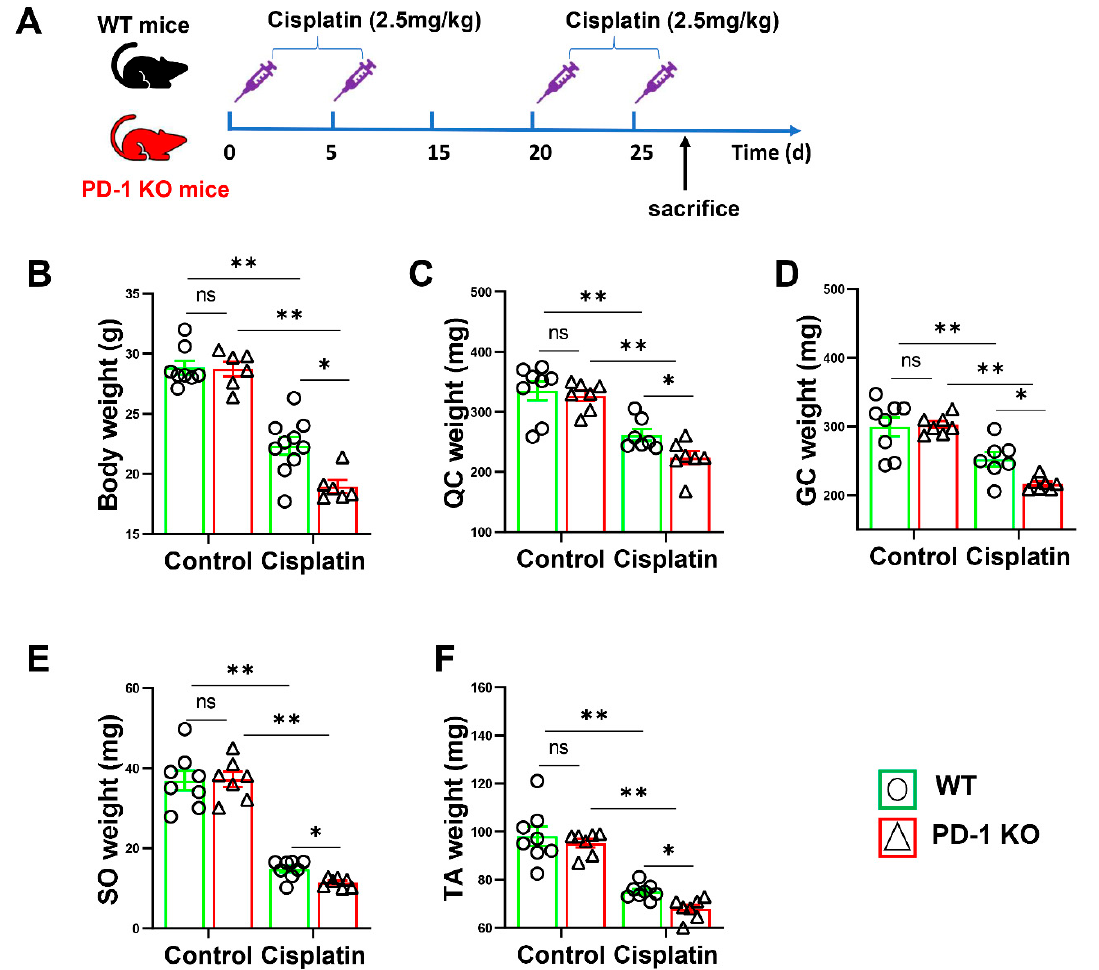
Figure 2. PD-1 − / − contributed mice cachexia after cisplatin treatment. ( A ) The diagram shows the time of relevant interventions. ( B ) The body weight of WT and PD-1 -/- mice. ( C ) The weight of quadriceps (QC) muscle. ( D ) The weight of gastrocnemius (GC) muscle. ( E ) The weight of soleus (SO) muscle. ( F ) The weight of tibialis anterior (TA) muscle. n = 6–9 per group. * p < 0.05; ** p < 0.01; ns: non-significant. all values are mean ± SEM.